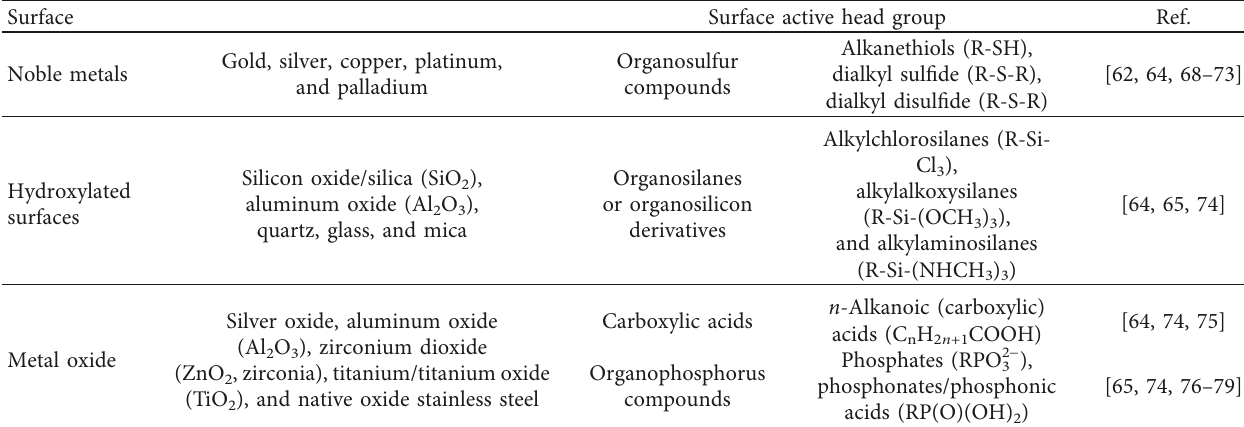
Table 3: Types of SAMs according to the